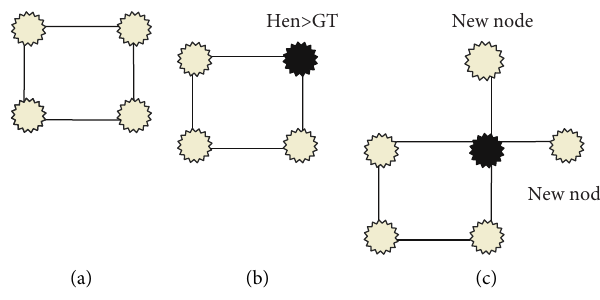
Figure 1: New neurons generated from boundary neurons.